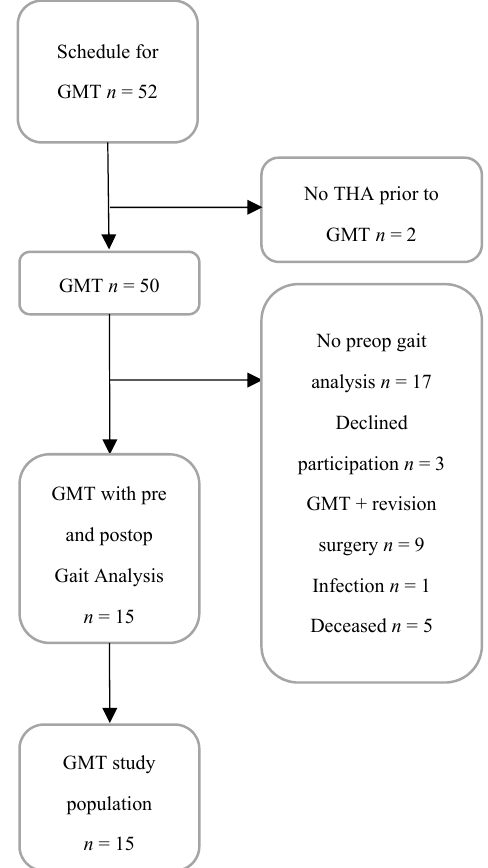
Figure 1. Flowchart of included patients.